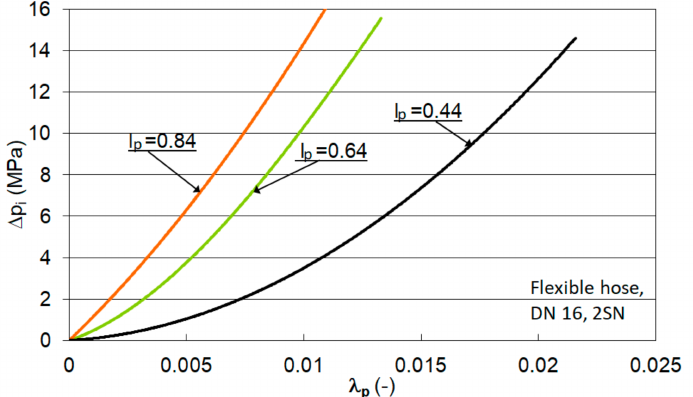
Figure 8. Influence of internal pressure ∆ p i on volume expansion coefficient λ p of hoses with a nominal diameter of 16 mm (DN16) and two carcass layers (2SN) vs. their length l p